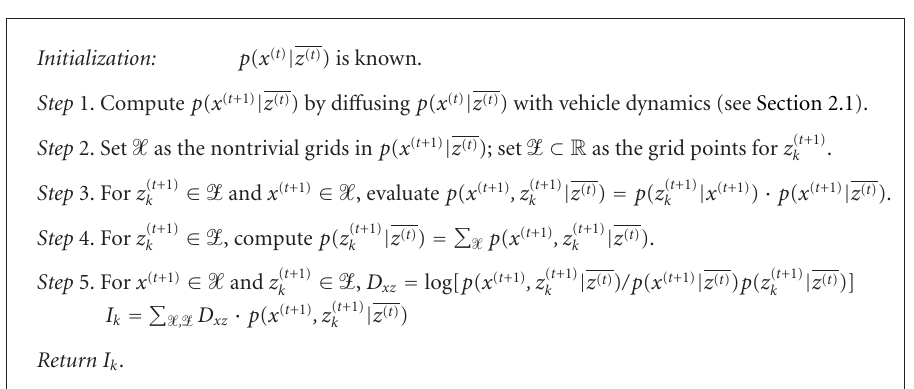
Table 2: Computation of mutual information I ( X ( t +1) ; Z ( t +1)